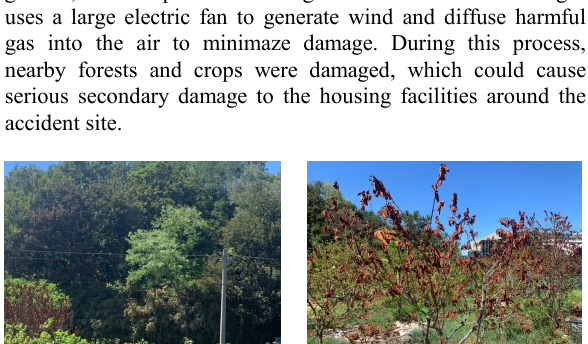
Figure 7. Final products by UAV mapping at chemical